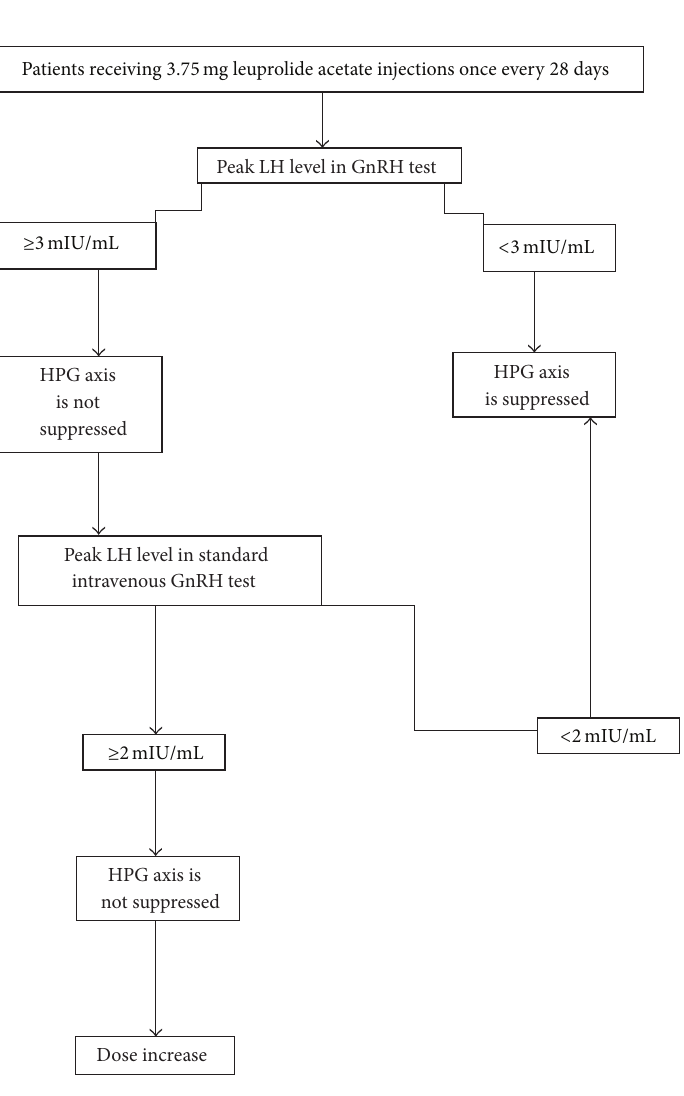
Figure 1: The flowchart used in the monitoring of the suppression of HPG axis and dose